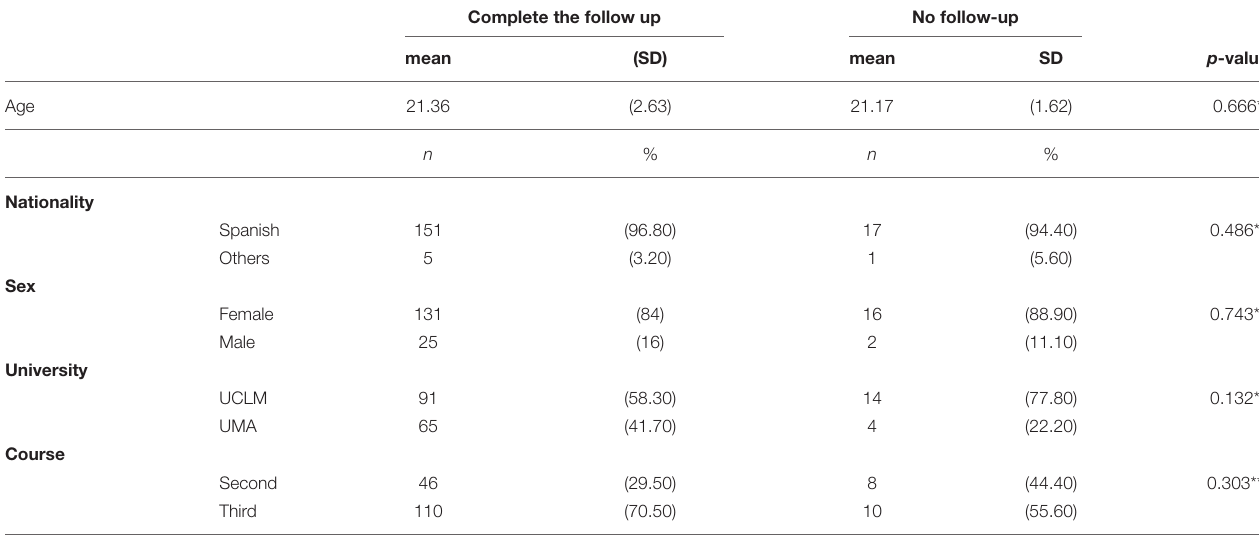
TABLE 2 | Differences between the groups of students who completed and not the follow-up.